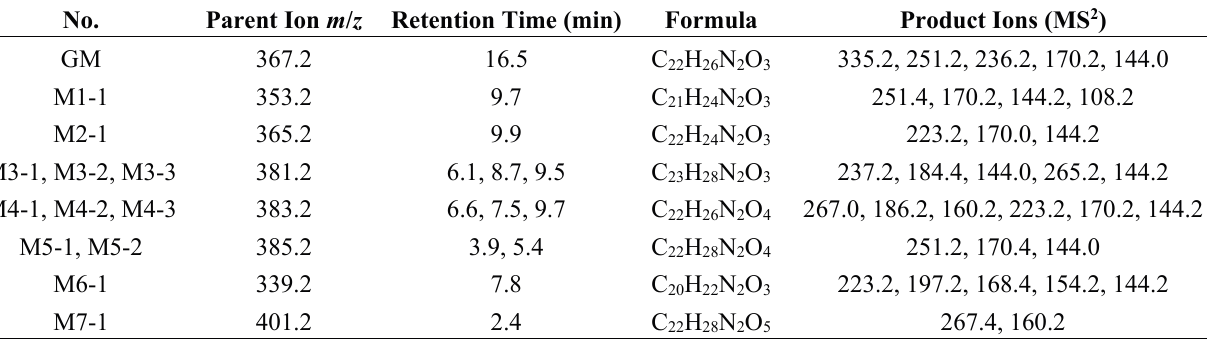
Table 1. Masses, retention times, and formulae of GM and its metabolites in rat and human liver microsomes, as detected by LC/MS/MS with positive electrospray ionization.